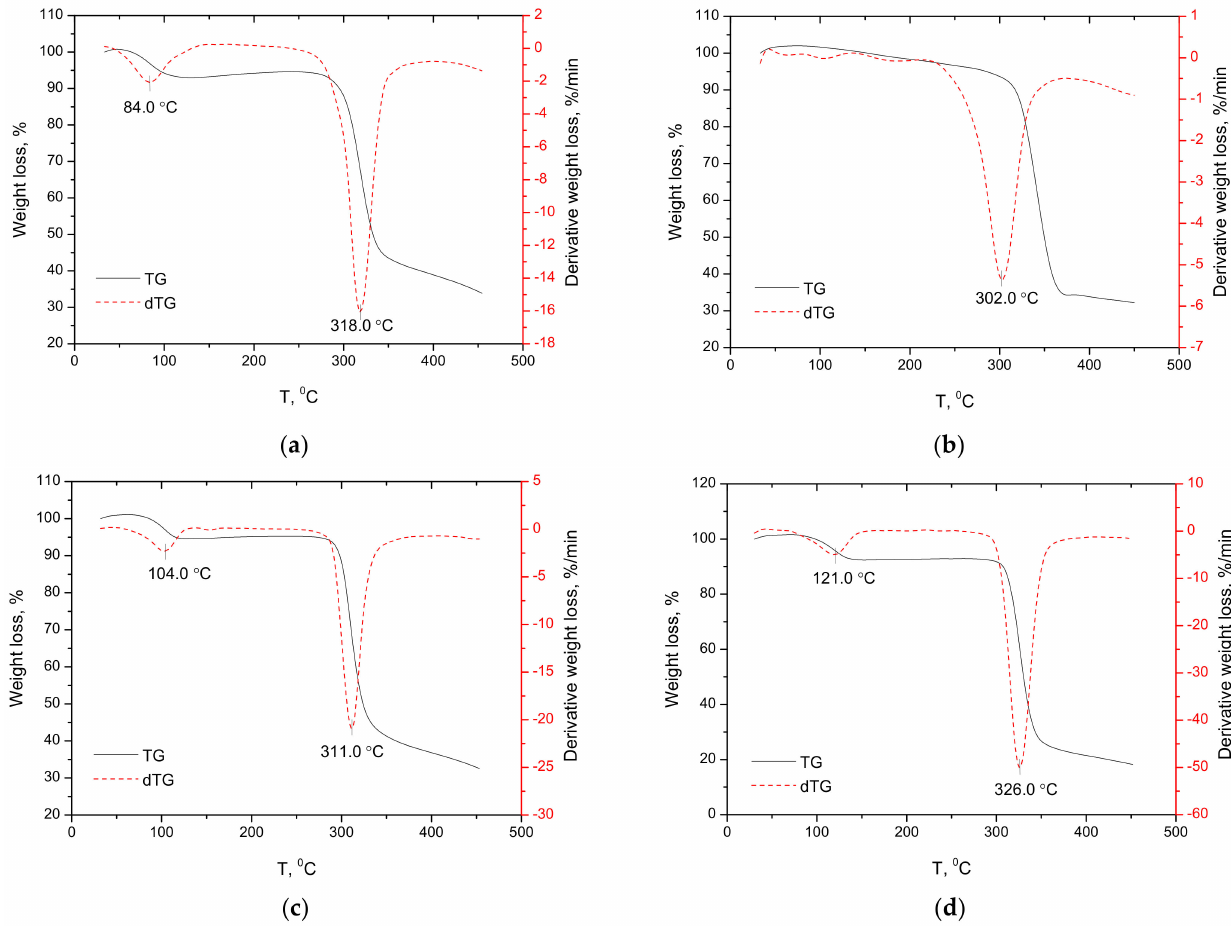
Figure 17. TG/DTG curves of β -CD ( a ) (in nitrogen)), anabasine- β CD 1:1 ( b ); 1:2 ( c ); 1:3 ( d ) complexes at a constant heating rate of 10 degree/min (in